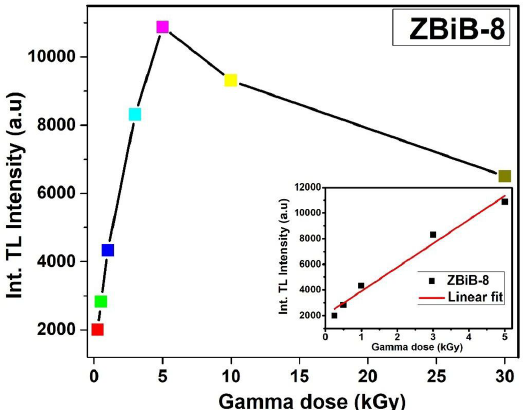
Figure 11. TL dose response curve for ZBiB-8 glass in the dose range of 0.25 to 30